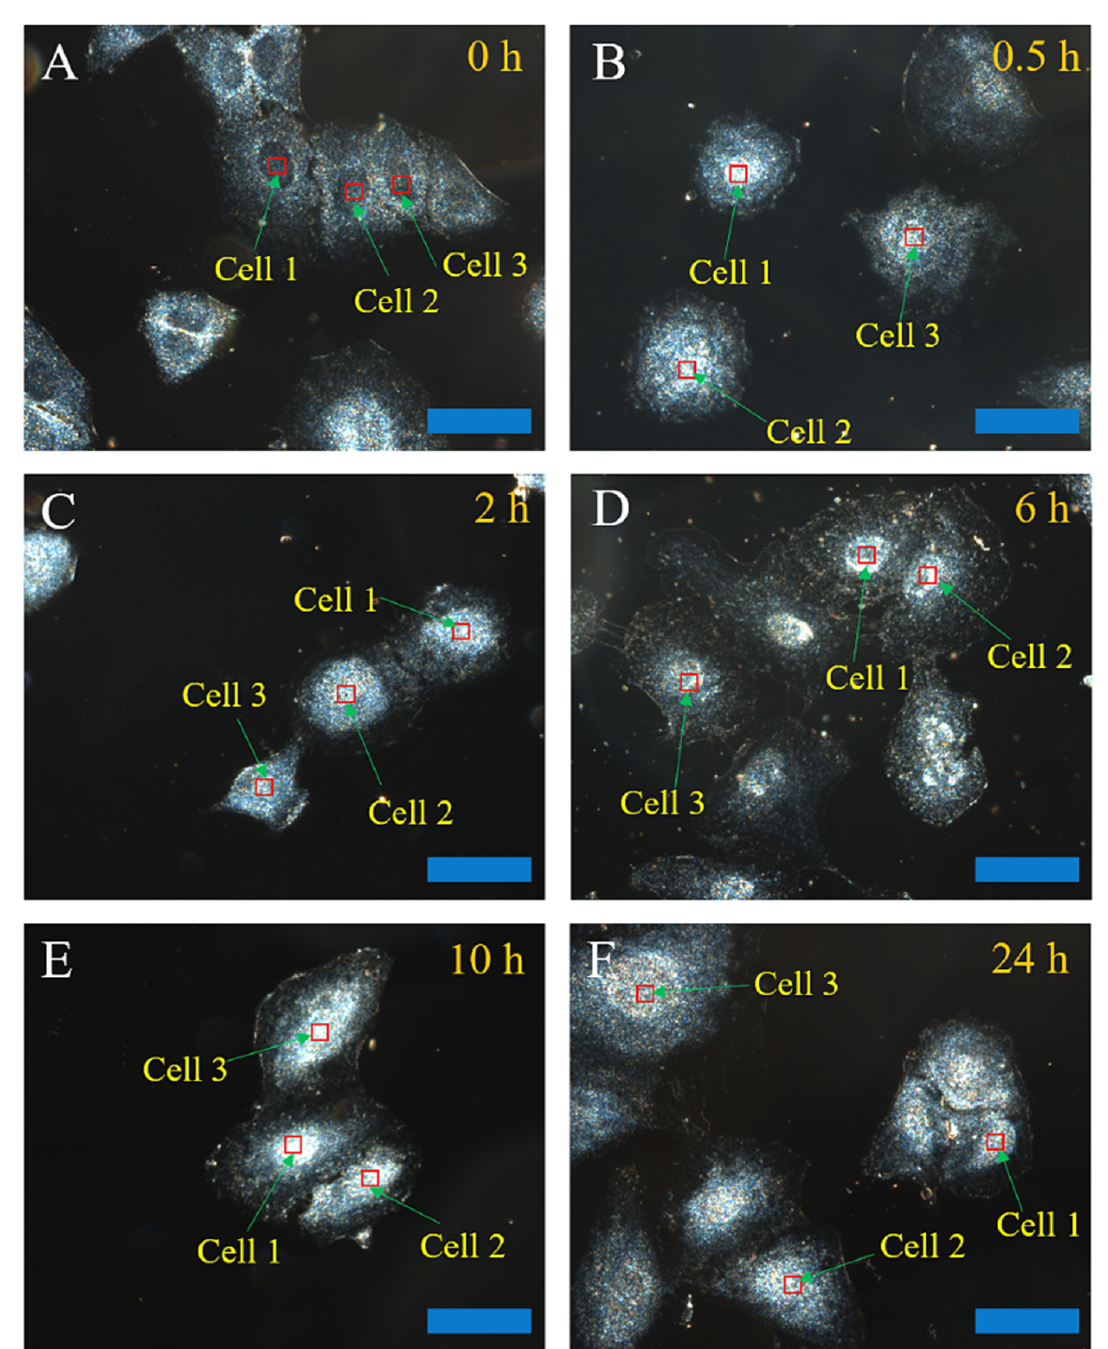
Figure 2. Dark-field images of cells incubated without CNDs ( A ) or with 750 µg/mL of CNDs for different incubation times ranging from 0.5 h to 24 h ( B – F ). All of the scale bars are 4 µm.